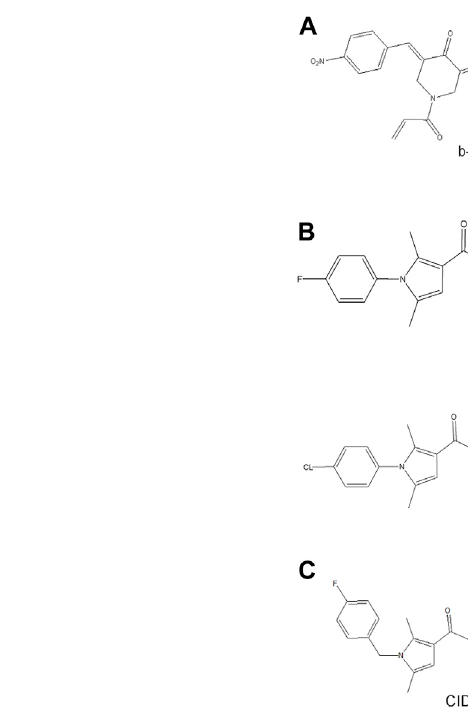
Frontiers in Pharmacology |